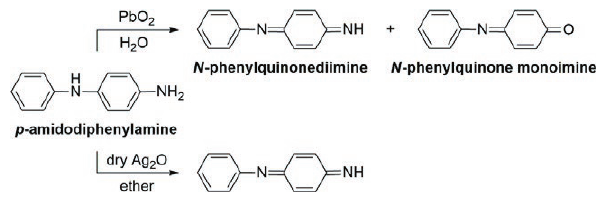
Figure 7. Oxidation of p -amidodiphenylamine.